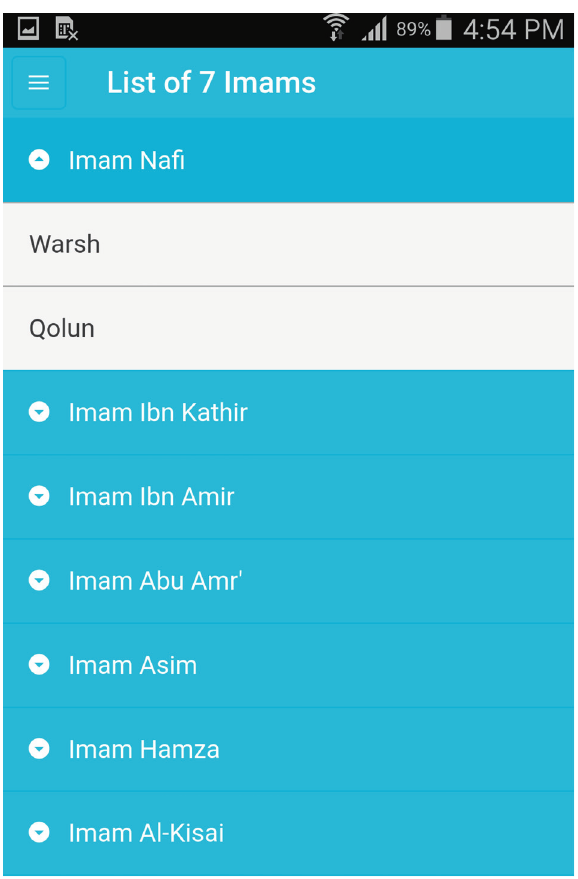
Figure 8: List of 7 Imams